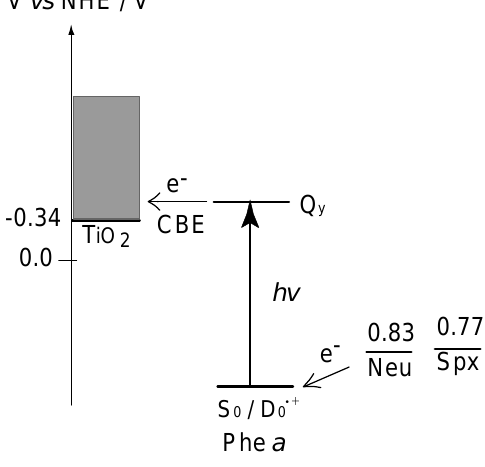
transfer from neurosporene ( n = 9) or spirilloxanthin ( n = 13). The gap in